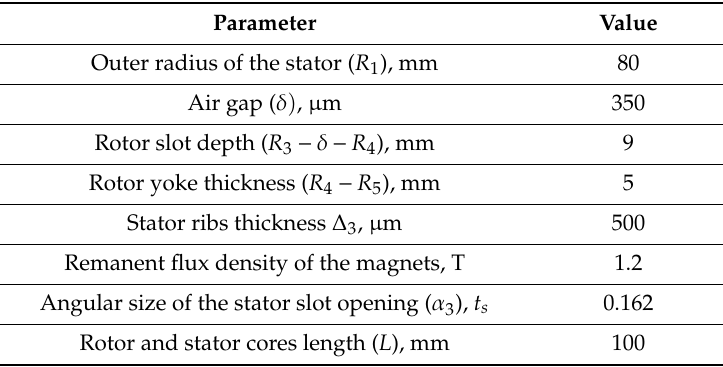
Table 6. The varied FSG parameters during the optimization.